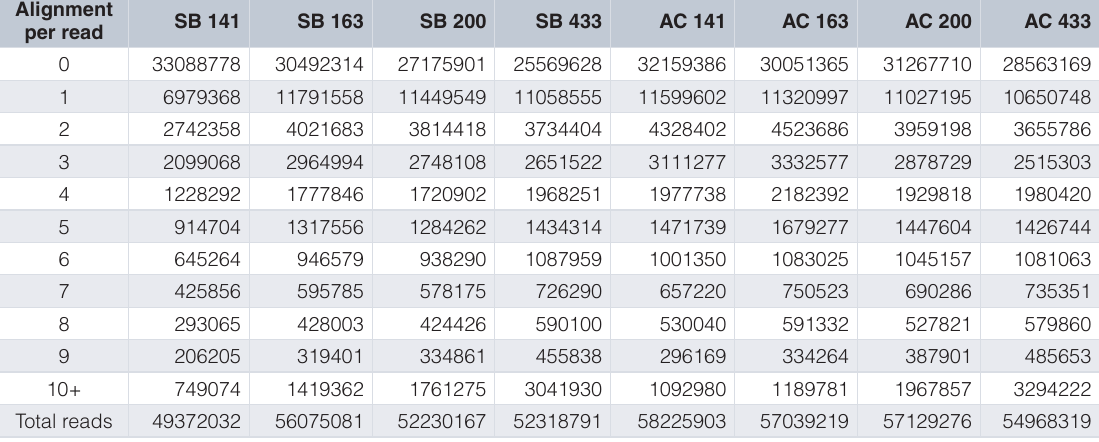
Supplemental Table S3. Mapping of Illumina reads to S. salar EST data. Numbers of reads aligning to salmon reference for each sample.